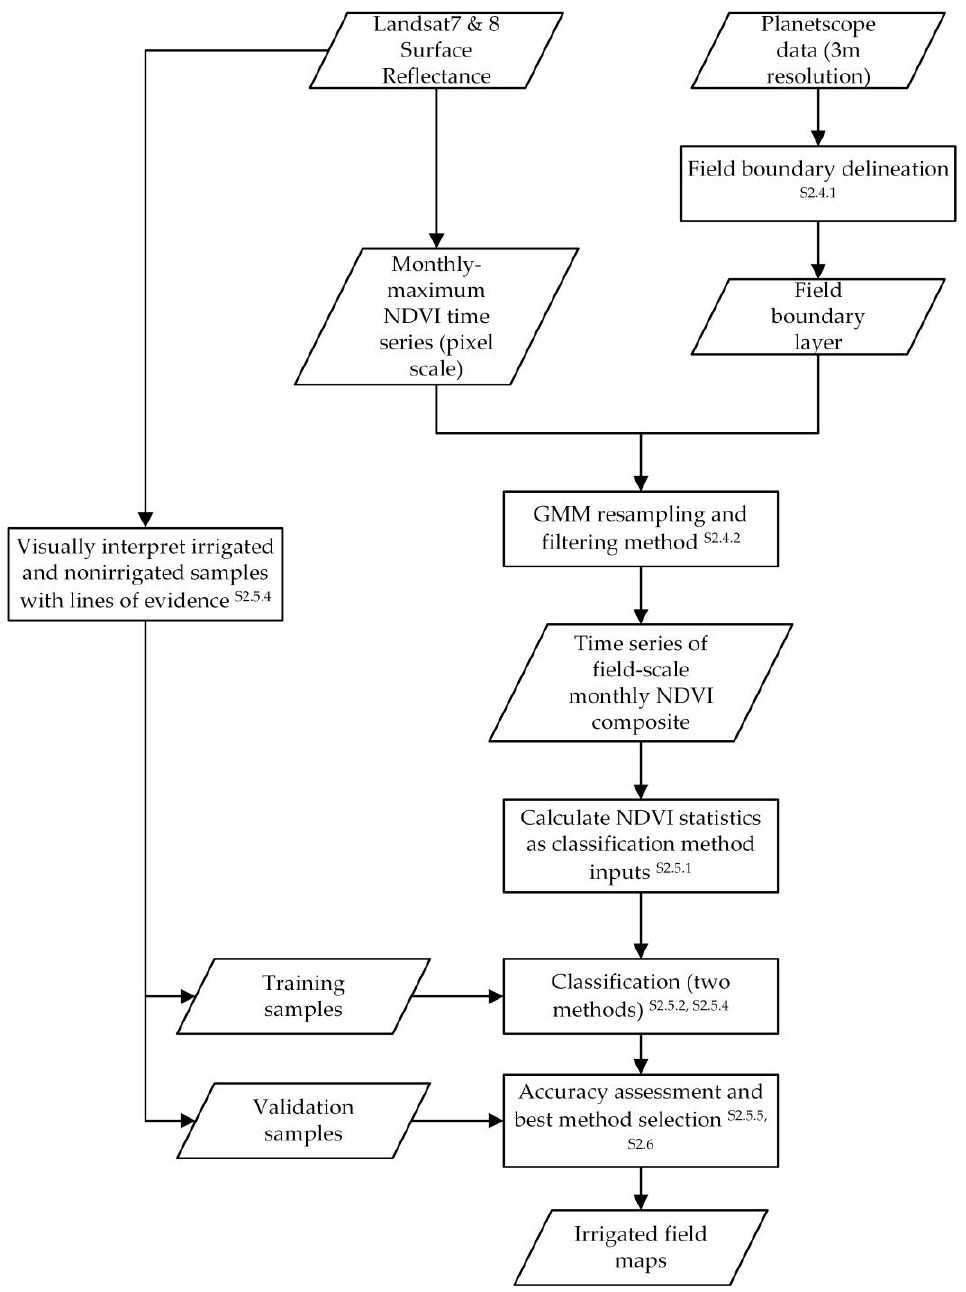
Figure 3. The flow diagram of the methodology. Sections 2.4.1., 2.4.2., 2.5.1., 2.5.2., 2.5.4., 2.5.5., and